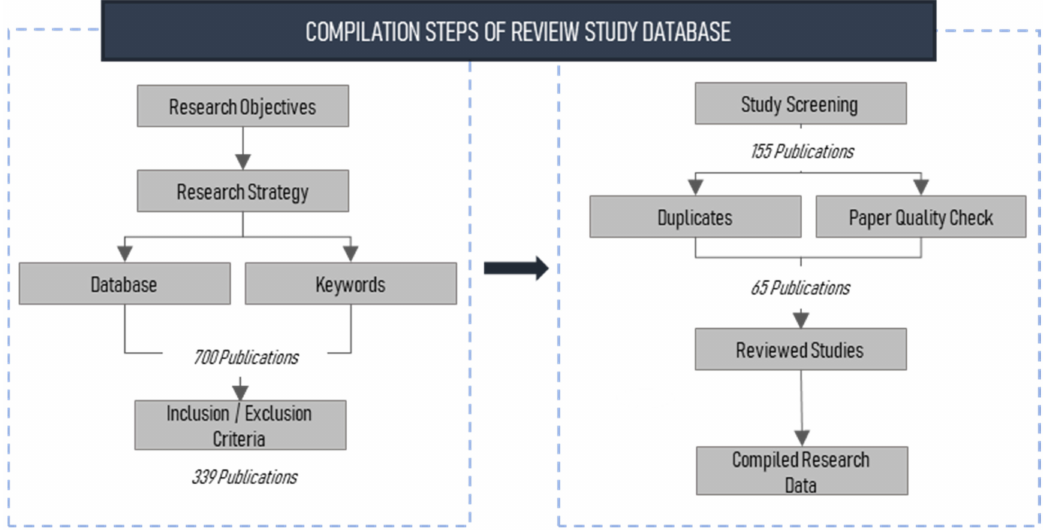
Figure 4. Flow diagram outlining the review